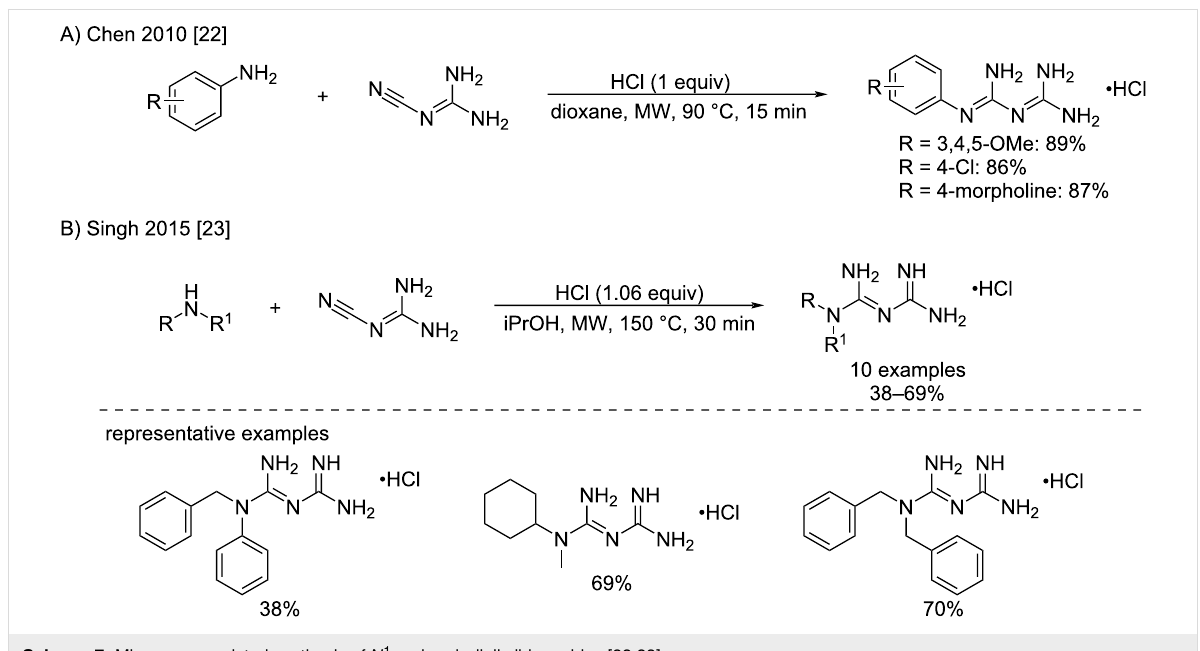
Scheme 7: Microwave-assisted synthesis of N 1 -aryl and -dialkylbiguanides